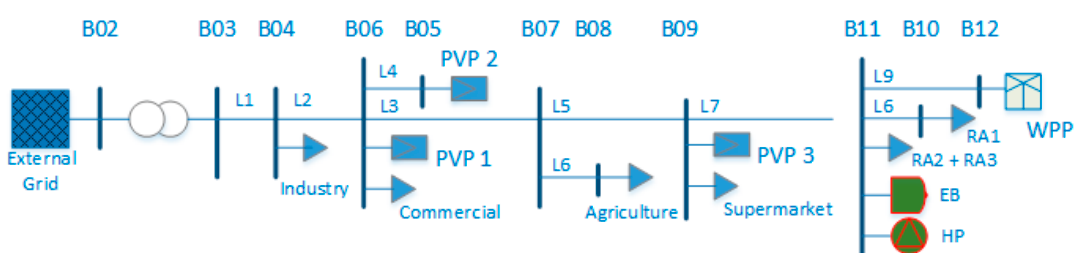
Figure 5. Single Line Diagram of representative distribution Medium Voltage (MV) feeder.